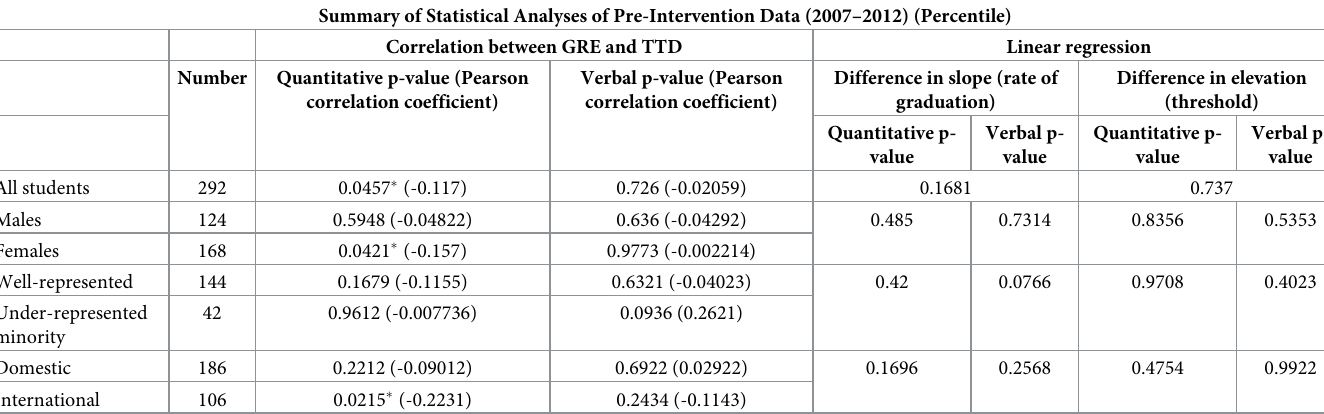
Table 5. Summary of statistical analysis regarding GRE percentiles and time to degree.